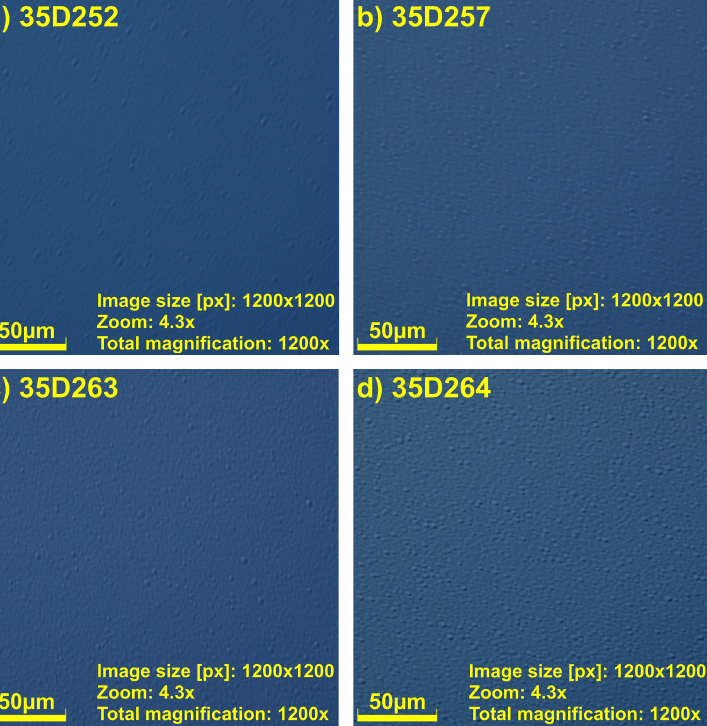
Figure 5. The Nomarski optical microscopy pictures of four InAs/AlSb T2SL samples. ( a ) 35D252, ( b ) 35D257, ( c ) 35D263, ( d )